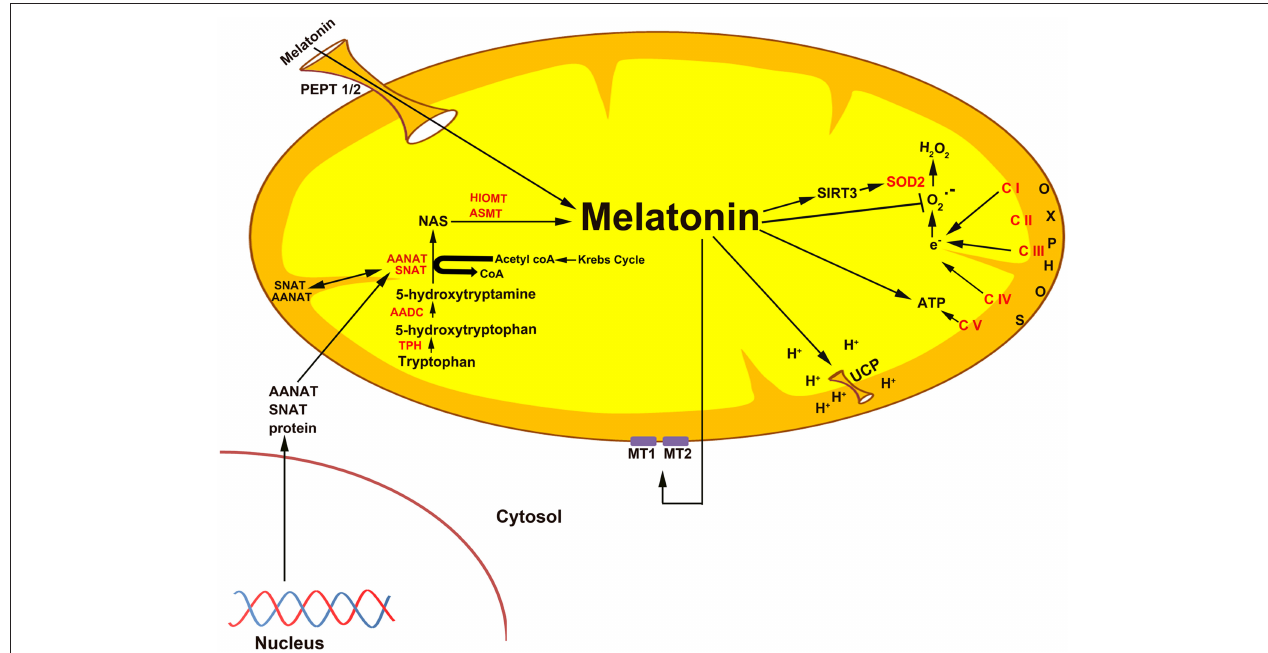
FIGURE 3 | The association of melatonin with mitochondria is predicted on the basis of the origin of these organelles as specified in the text. Current evidence suggests that melatonin is synthesized in some species in the mitochondrial matrix as illustrated here. Also, exogenously administered melatonin concentrates in the mitochondria ( 102), i.e., melatonin is a mitochondria-targeted agent. Given that melatonin functions as an antioxidant is particularly important in mitochondria since these organelles are a major site of free radical generation. In addition to directly neutralizing reactive oxygen species, melatonin also stimulates the antioxidant enzyme superoxide dismutase (SOD2), an action that involves an elevated level of sirtuin 3 (SIRT3) ( 39). Melatonin potentially enters mitochondria through the oligopeptide transporters, PEPT1/2 ( 103). Melatonin also influences mitochondrial membrane potential by influencing uncoupling protein (UCP). Also, melatonin from the matrix may leak out of the mitochondria to interact with the melatonin receptors, MT1 and MT2, to control the release of cytochrome c.